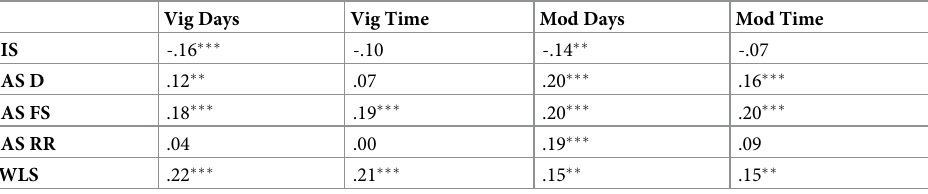
Table 9. Correlations of BIS/BAS and SWLS with exercise variables, controlling for age and gender (Study